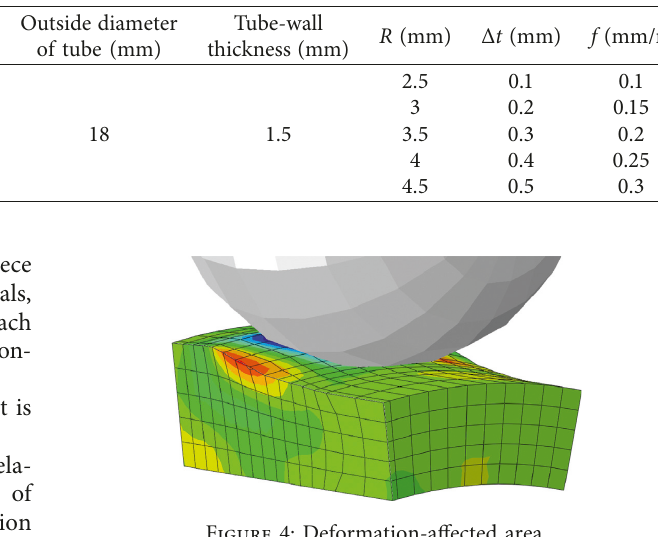
Table 1: Properties and process parameters of the blank tube.